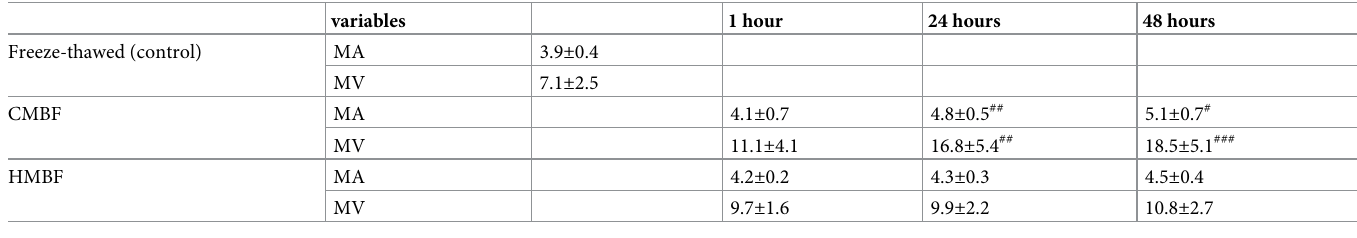
Table 2. Changes in area average diameter (MA), volume average diameter (MV), of the MFG with time after fortification. (n =